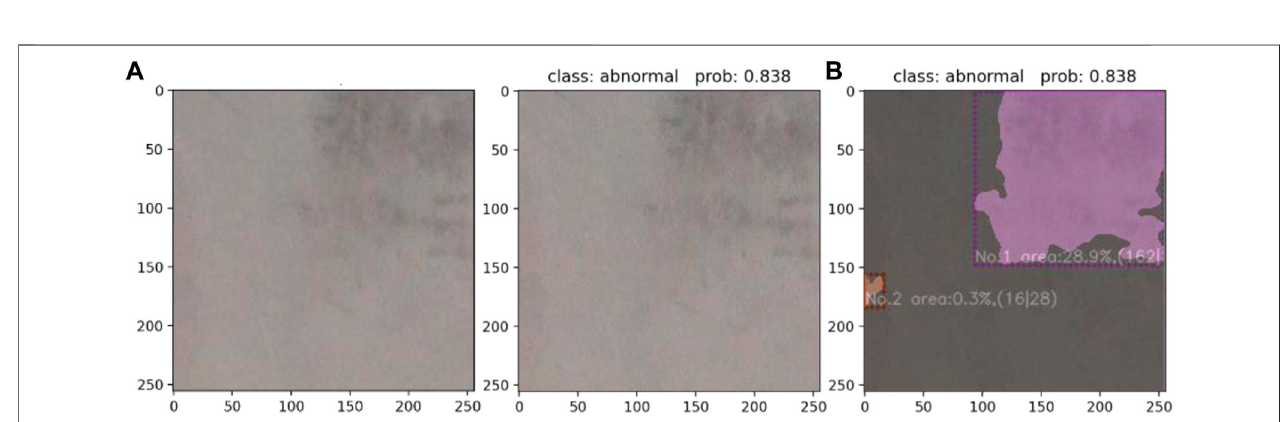
FIGURE 10 | Prediction and quanti fi cation results for mild chromatic aberration: (A) Original image (B) Prediction and quanti fi cation results.